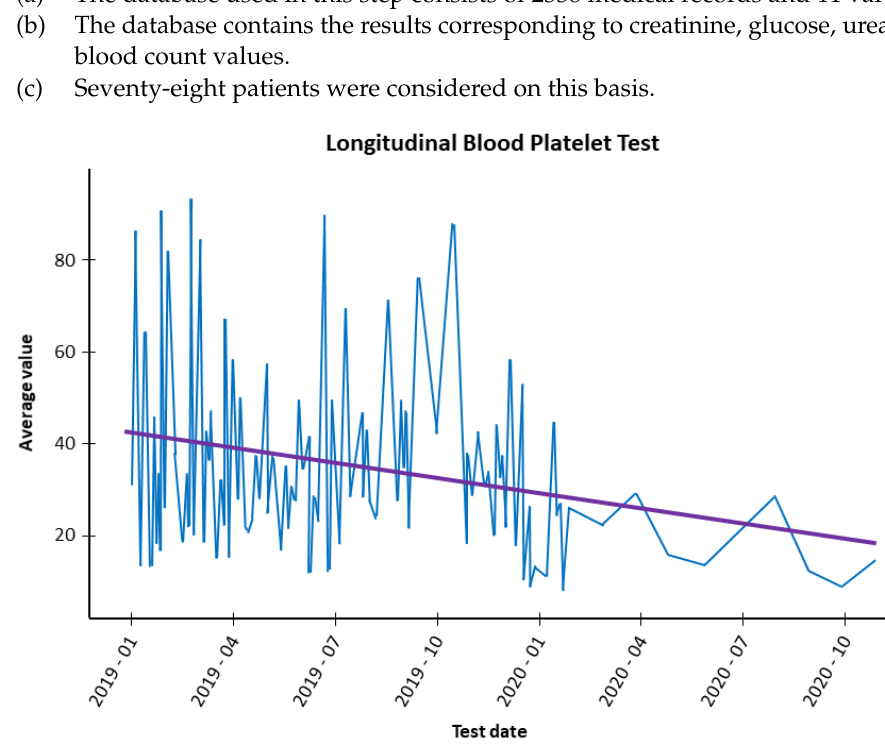
Figure 8. Linear Regression—temporal analysis of the impact of the drug under